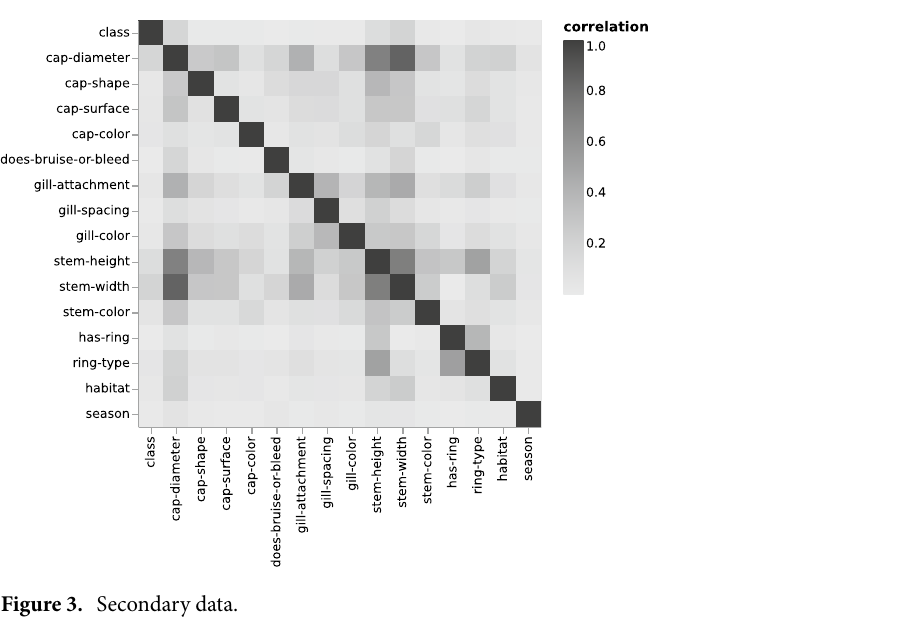
Figure 3. Secondary